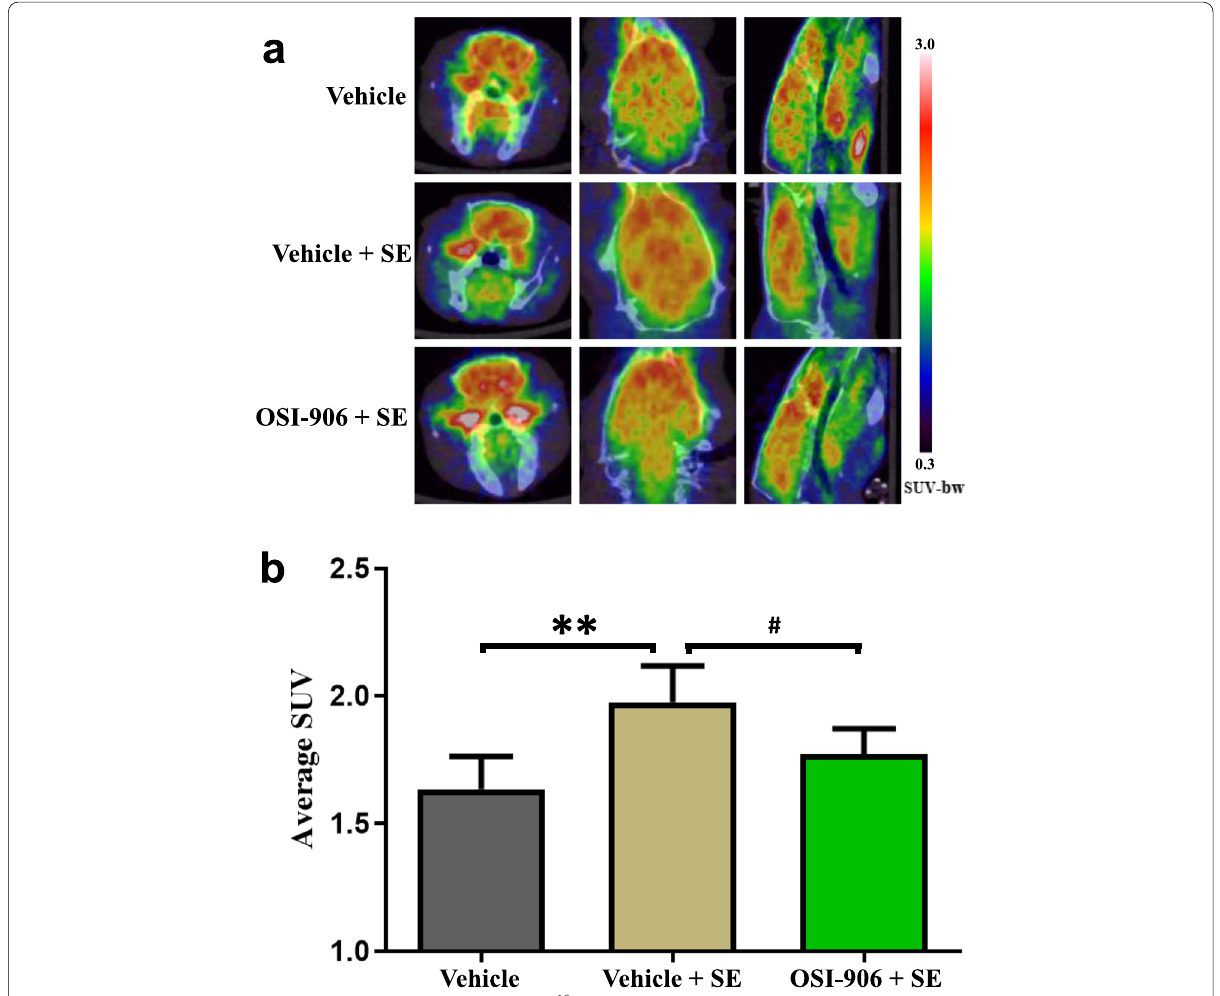
Fig. 5 OSI-906 decreased the glucose uptake 1 h after seizures. ( a ) 18 F-FDG micro-PET/CT quantification of glucose metabolism in vivo. ( b ) Compared with the normal control group, the average whole-brain SUV value was significantly increased 1 h after pilocarpine-induced epileptic seizures. Treatment with 50 mg/kg of OSI-906 significantly reduced the value of glucose uptake in the brain ( n ** P < 0.01, # P <